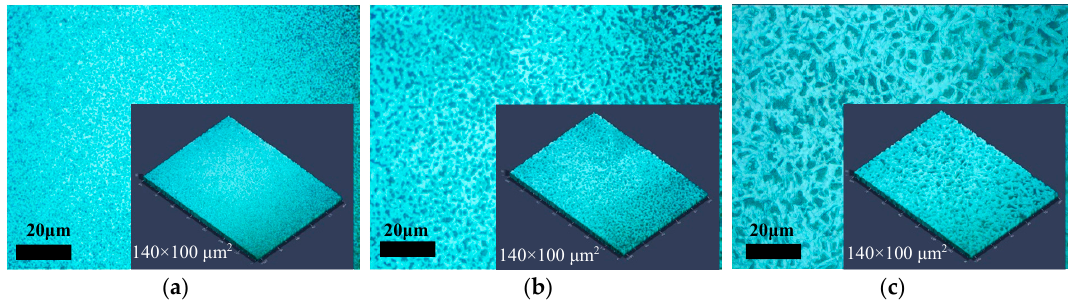
Figure 4. Optical images of spun-on perovskite films at different concentrations. The solution concentrations are ( a ) 10 wt.%; ( b ) 30 wt.%; and ( c ) 50 wt.%. This figure shows that high concentrations result in the formation of large crystals, and therefore, occurrence of crystallization dewetting.